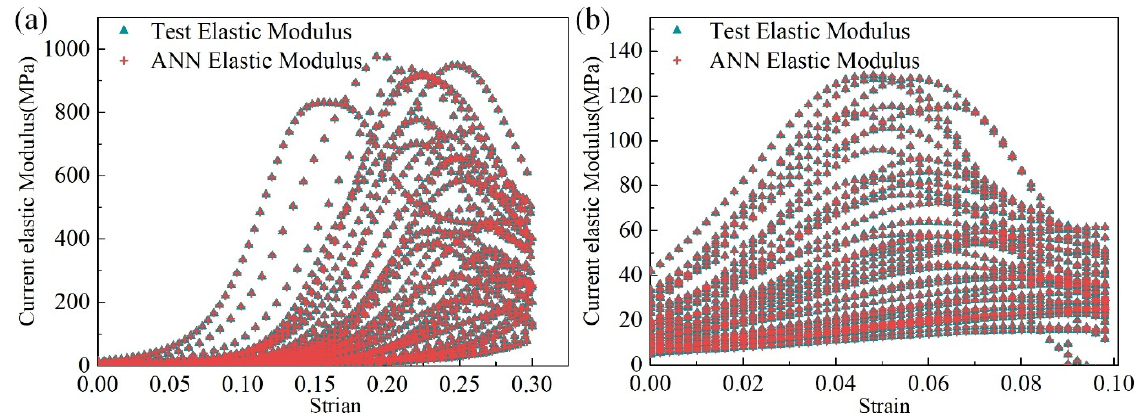
Figure 8. Comparison between training data and ANN model output: ( a ) training results of the loading stage in the y –direction and ( b ) training results of the loading stage in the x –direction.